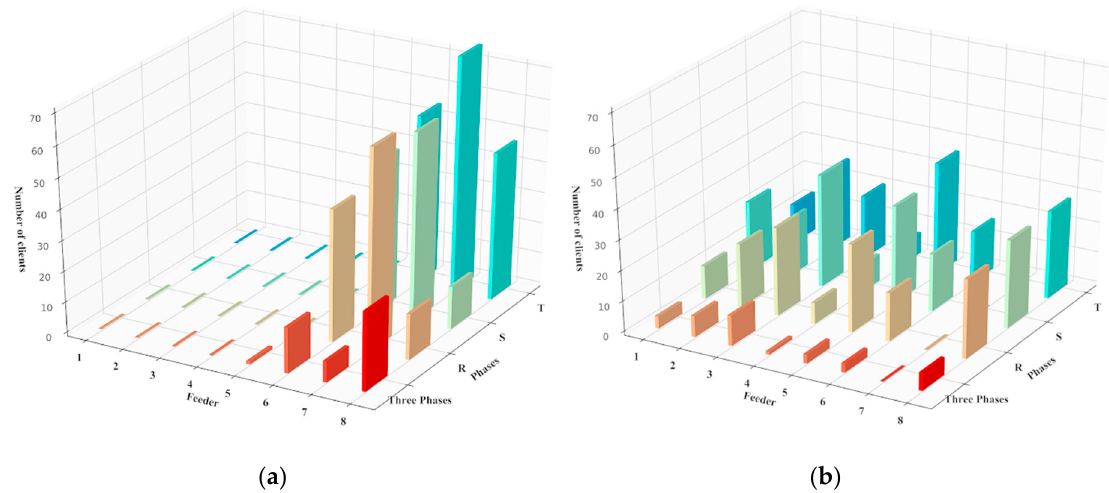
Figure 1. An example of single-phase (in orange, green, and blue) and three-phase (in red) client distribution per low-voltage (LV) feeder in two secondary substations ( a ) and ( b ) of Smartcity Malaga Living Lab.